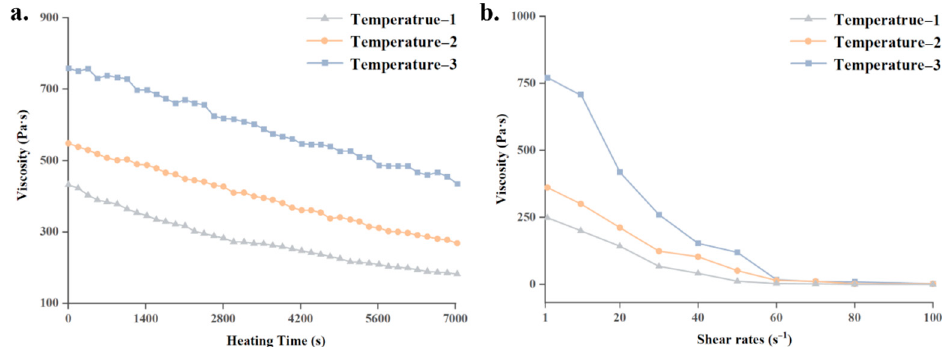
Figure 9. Rheological properties of PLCL: ( a ) viscosity curve of PLCL with varying heating time and temperature; ( b ) viscosity curve of PLCL with varying shear rate and temperature. temperature; ( b ) viscosity curve of PLCL with varying shear rate and